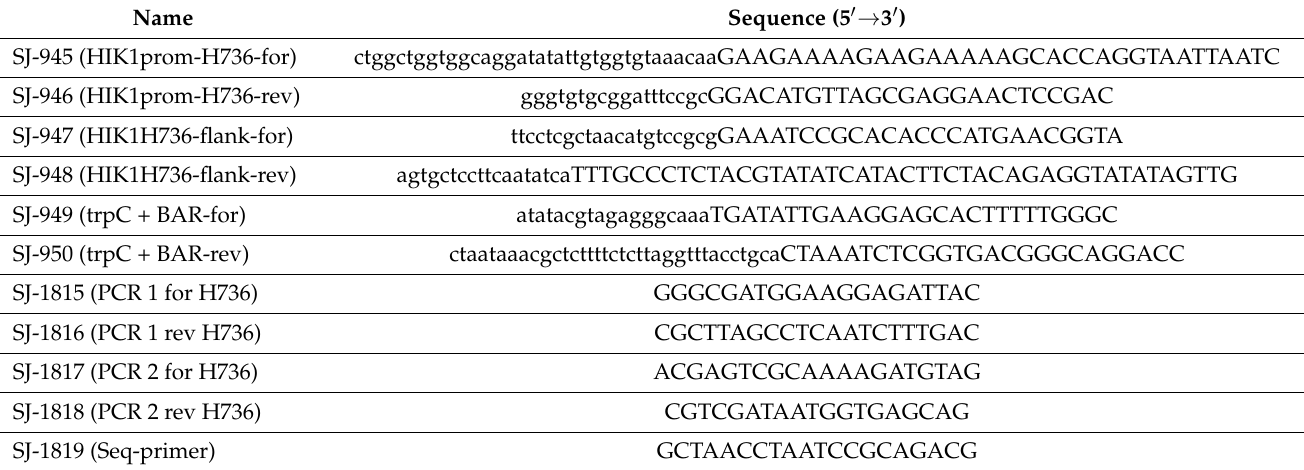
Table 1. List of oligonucleotides used in this